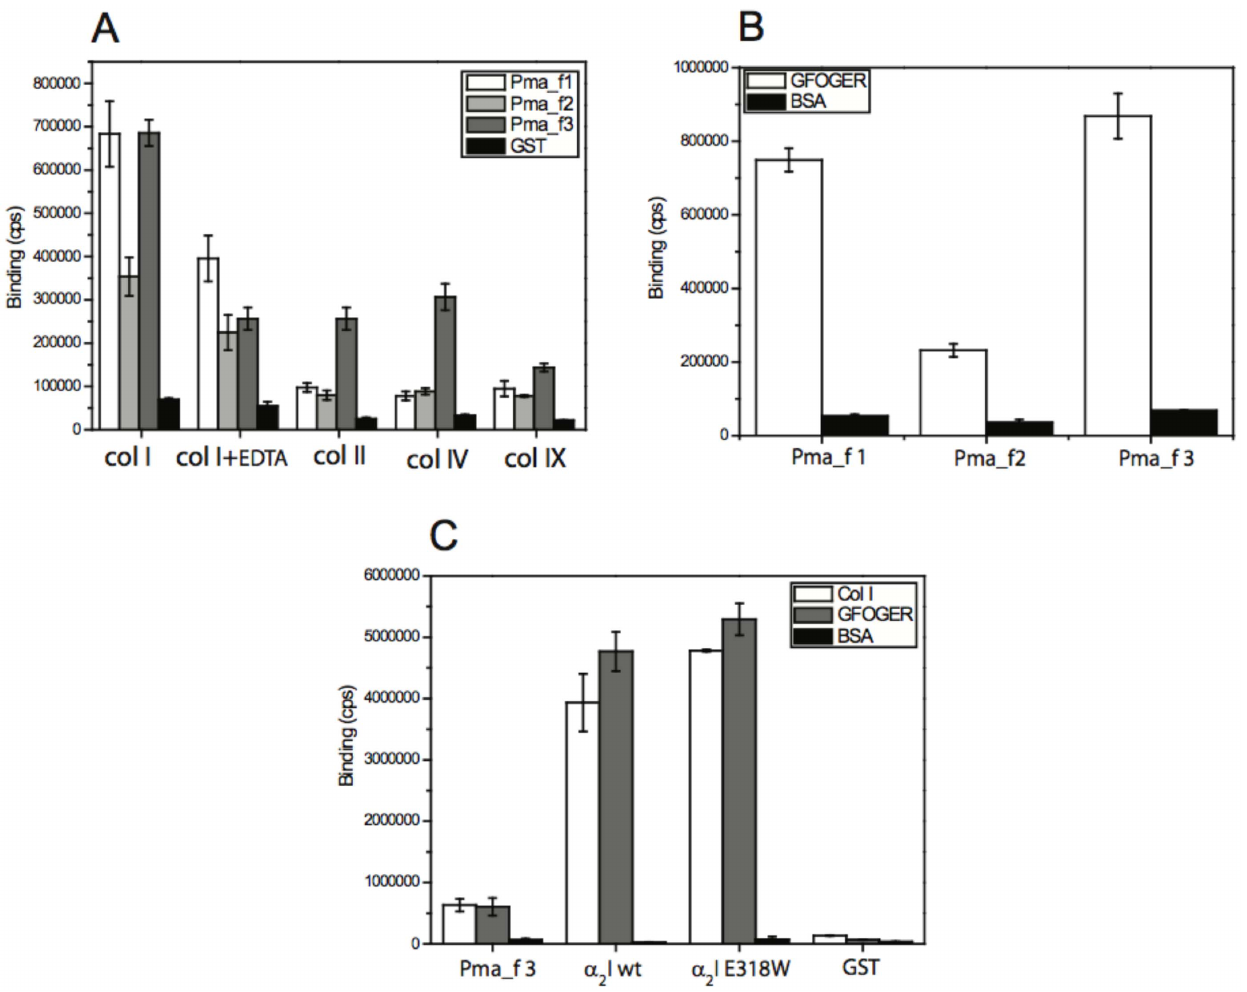
Figure 6. Lamprey a I domains recognize mammalian collagens and the GFOGER-motif in a metal-dependent manner. (A) Binding of Pma_f a I domains to various mammalian collagens at a fixed (400 nM) concentration. The EDTA concentration was 10 mM. GST binding serves as a negative control. (B) Binding of Pma_f a I domains to triple-helical GFOGER-tripeptide at a fixed concentration (400 nM). Binding to BSA serves as a negative control. (C) Binding of Pma_f3 a I, human a 2I wt, and human a 2I E318W domains to rat collagen I, GFOGER-peptide, and BSA. Binding of GST serves as a control.